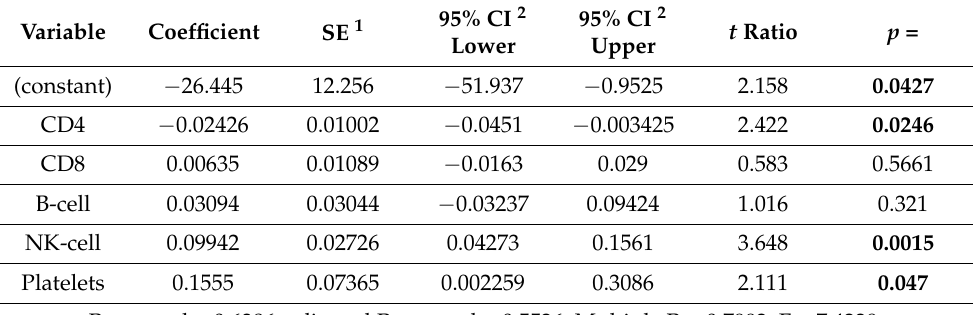
Table 4. Multiple regression analysis of mean circulating tumour cell (CTC) count per blood draw against absolute lymphocyte and platelet counts. CI: confidence interval. SE: standard error. Bold highlights signficant values ( p < 0.05).